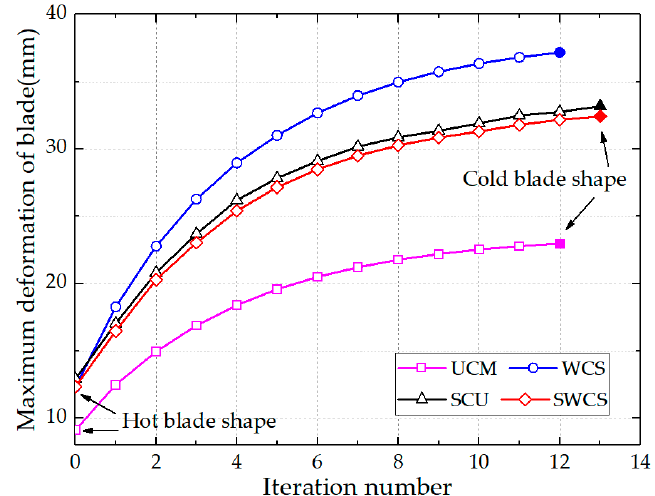
Figure 13. FEM of the hollow fan blade.